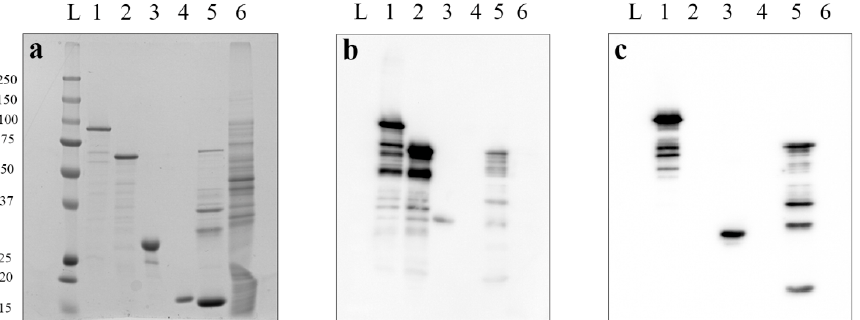
Figure 3. Interaction of obtained anthrax modified recombinant antigens with a polyclonal anti-rPA83 antiserum ( b ) and chimeric monoclonal PA-neutralising antibodies ( c ). L—protein molecular weight markers ladder (molecular weights, in kDa, are indicated on the left), 1—rPA83m, 2—rPA1+2, 3—rPA3+4, 4—Tobacco mosaic virus, 5—rPA63, 6— E. coli cell lysate. Electrophoresis analysis in 8–20% SDS-PAGE, staining by Coomassie G-250 ( a ). Western blot analysis with primary polyclonal antiserum to the non-modified rPA83 (1:5000) ( b ) or chimeric monoclonal PA-neutralising antibodies (1:5000) ( c ) and secondary HRP-conjugated antibodies (1:10,000). Original blot membranes’ images are presented in the Figure